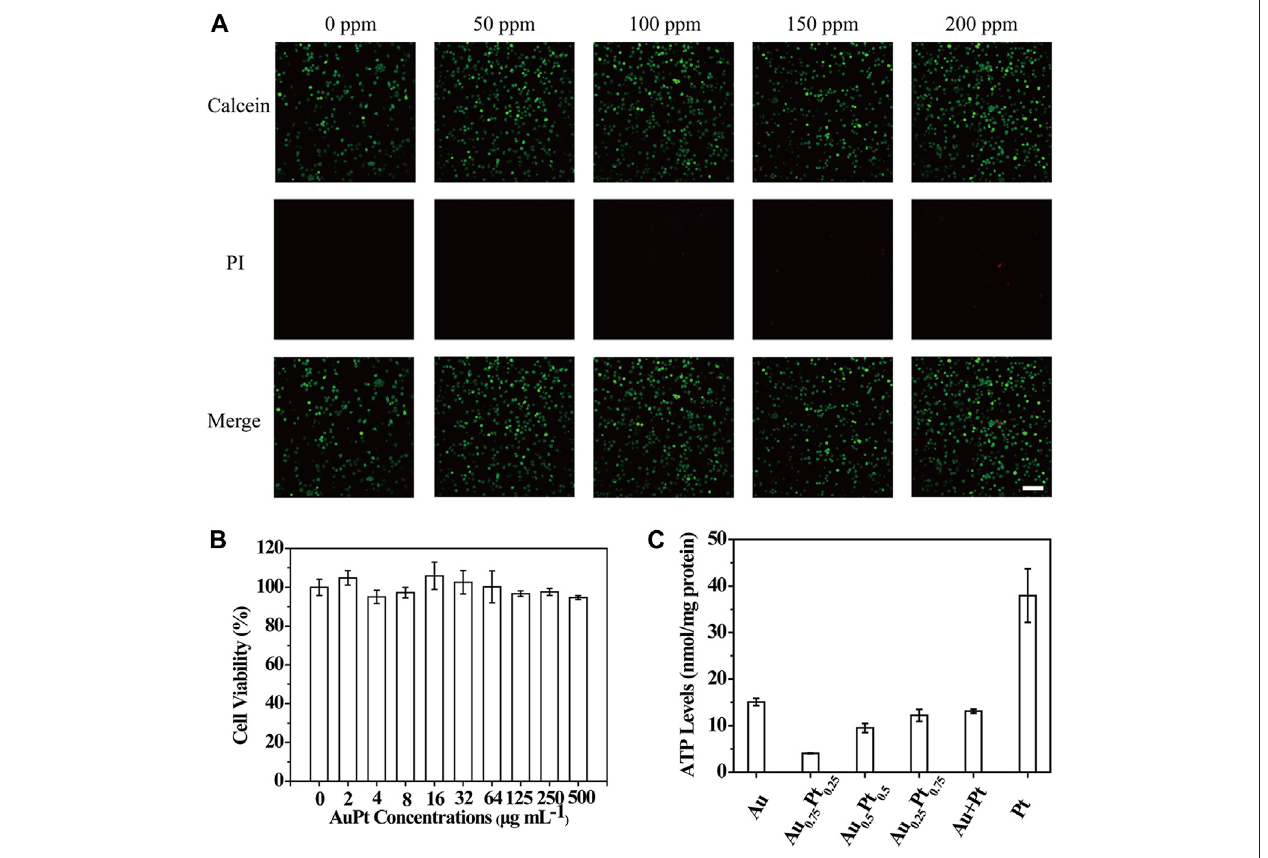
FIGURE 4 | In vitro performance of AuPt alloys. (A) PC12 cells treated with different concentrations of Au 0.75 Pt 0.25 . (B) PC12 cells with Au 0.75 Pt 0.25 treatment stained with Calcein (green, live cells) and PI (red, dead cells) for live/dead cell assay. (C) The intracellular ATP content of PC12 cells incubated with various AuPt alloys. The scale bar is 10 μ